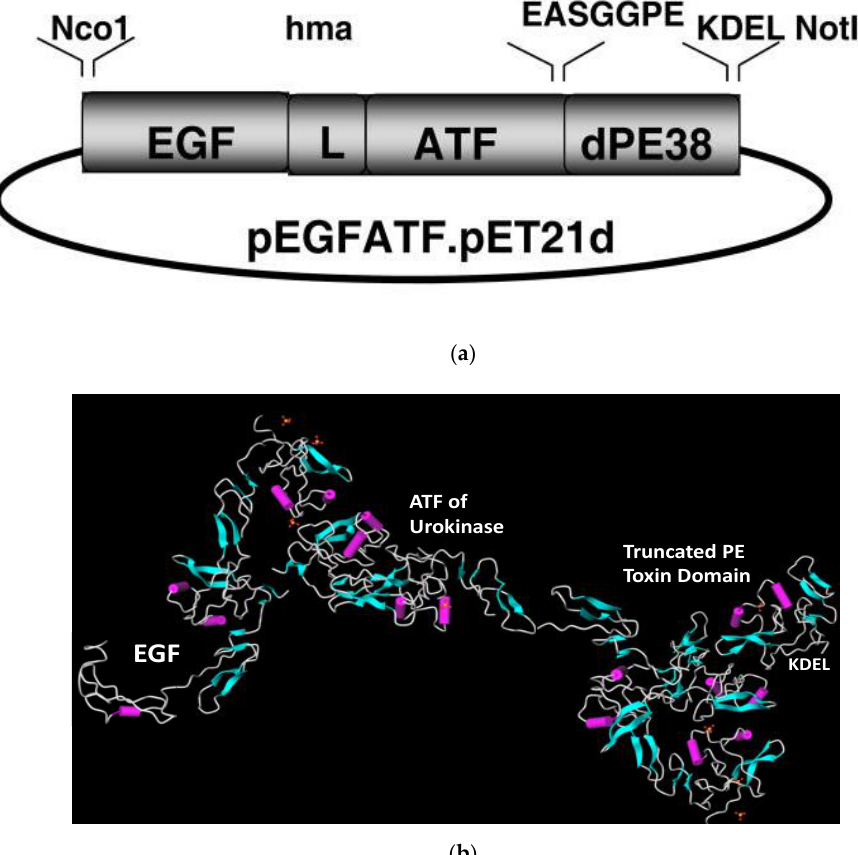
Figure 2. The bispecific LTT eBAT. ( a ) Expression vector for eBAT, human EGF, and the high affinity amino terminal fragment of urokinase linked to a deimmunized PE38KDEL molecule. The fusion gene (from 5′ end to 3′ end) consisted of an NcoI restriction site, the genes for human EGF, an ATG initiation codon, the downstream 135-amino terminal fragment (ATF) from uPA linked by a 20 amino-acid linker (L) of human muscle aldolase (hma), the 7 amino-acid EASGGPE linker, the first 362 amino acids of the pseudomonas exotoxin (PE) molecule with KDEL at the C terminus, and a NotI restriction site at the 3 (cid:48) end of the construct. ( b ) The ribbon model was assembled using MolView AGPL free software from crystallographic data obtained from the RCSB Protein Data Bank and is not an exact rendering. Accession numbers for crystallographic data are 1IKQ ( Pseudomonas exotoxin A), 2KV4 (EGF), and 1URK